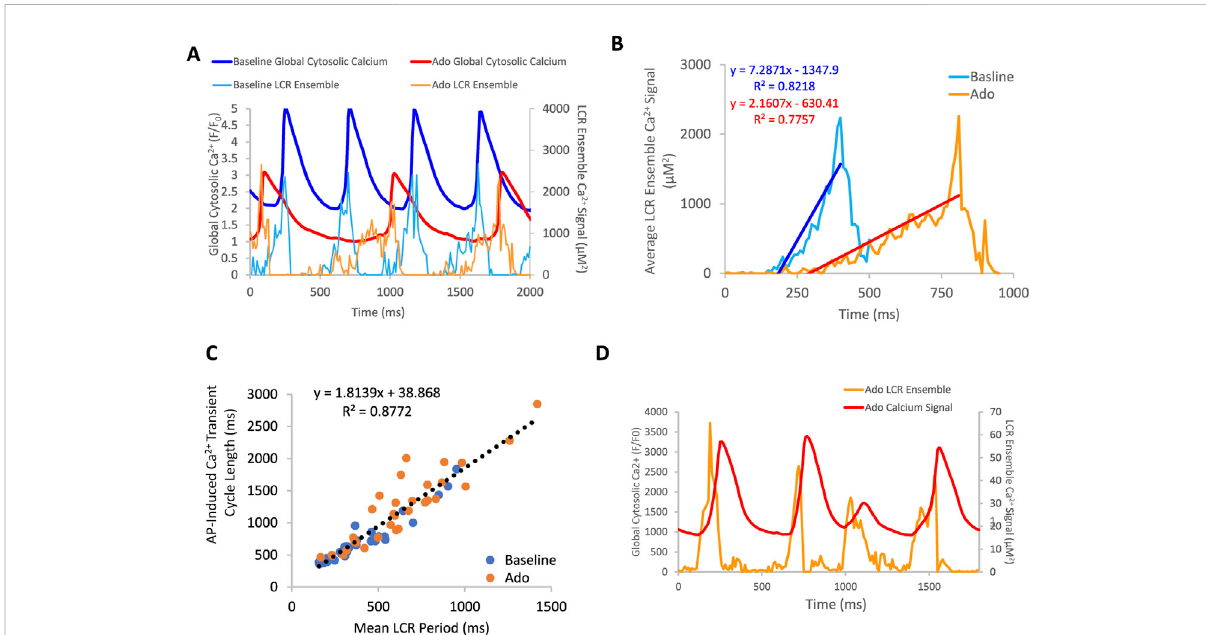
FIGURE 7 (A) an example of a rhythmically fi ring SANC that decreases in rate of LCR ensemble growth in response to adenosine. There is an overall decrease in global cytosolic Ca 2+ with adenosine compared to baseline. Panel (B) depicts the average LCR ensemble growth rate of 5 cycles at baseline and with ado. The average LCR ensemble growth rate decreased to 42% of baseline with adenosine. This decrease re fl ects the changes in intracellular Ca 2+ availability, manifesting in changes to LCR parameters. This results in an extended time period of Ca 2+ cycling between AP- induced Ca 2+ transients. Panel (C) , the correlation between mean LCR Period (3 – 7 beats) and AP-induced Ca 2+ transient cycle length is reduced at longer cyclelengths.At baseline,thereisastrongcorrelationbetween APCLandLCRperiod,indicating robustclockcoupling ( n =35).Adenosine, in the same population of cells, the mean APCL and LCR period increased for many cells. For a subset of cells, mean APCL increased more than mean LCRperiod,indicatingreduced fi delityofclockcouplingindicatedbytheorangecirclesthatdigressupandleftwardfromthelineartrendline(dashed line). The linear trendline includes baseline and ado values. Panel (D) , an example of a SANC with ado where LCR ensemble growth propagation was insuf fi cient and failed to generate an AP, resulting in clock uncoupling and a “ failed AP attempt ”